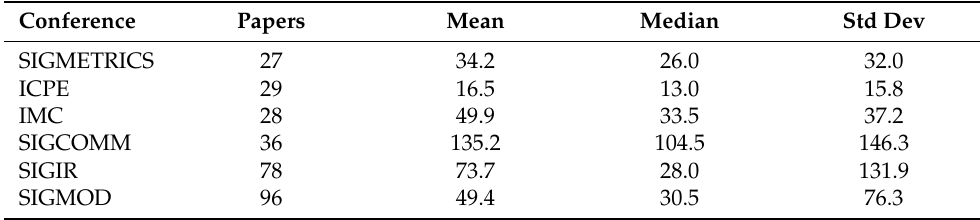
Table 2. Mean and median citations after 54 months for SIGMETRICS and other contemporaneous